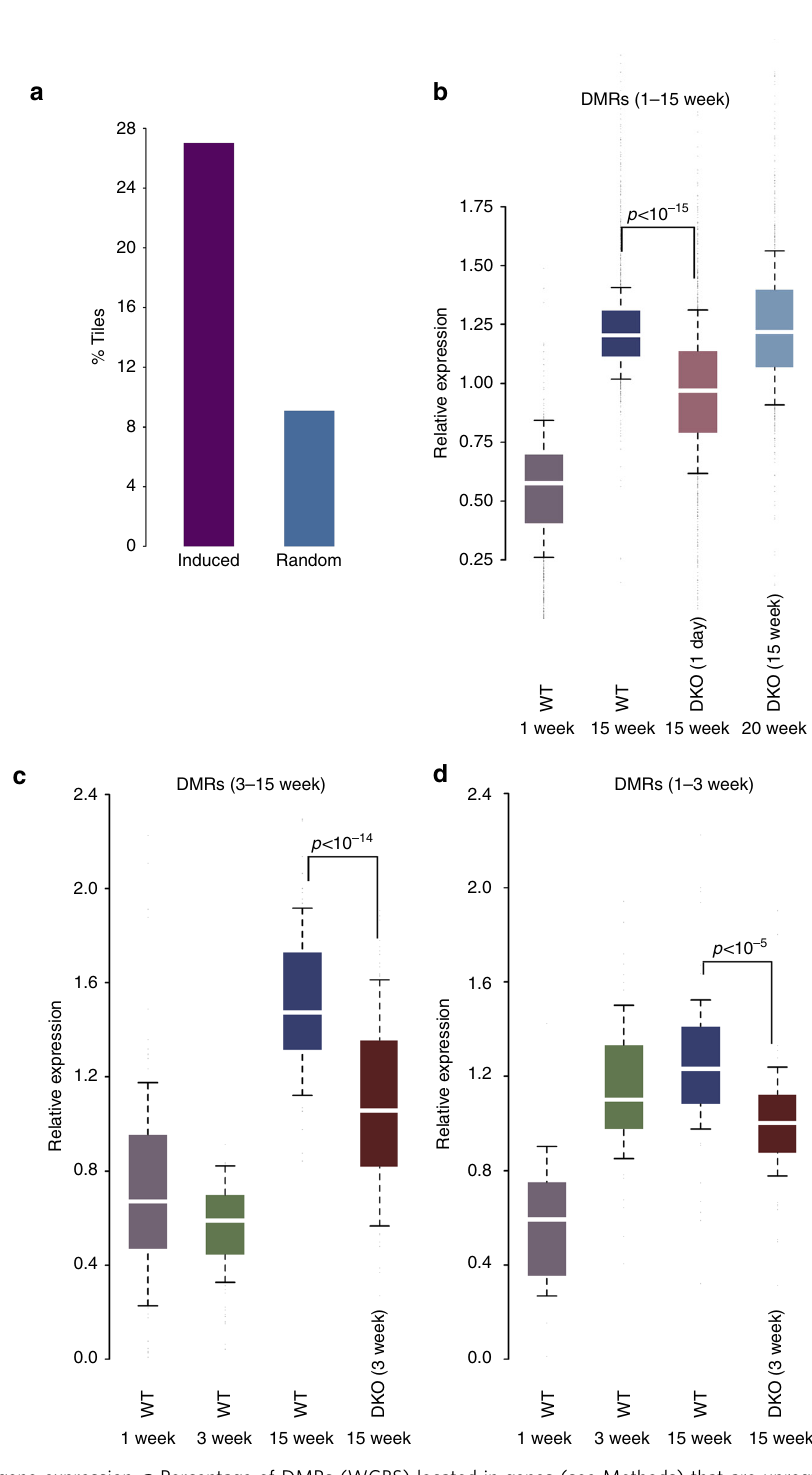
Fig. 3 Demethylation and gene expression. a Percentage of DMRs (WGBS) located in genes (see Methods) that are upregulated with age ( n = 8500) compared to randomly selected DNA segments ( p value <10 − 27 , z -test of proportions). b Box plots of relative expression (normalized fragments per kilobase million (FPKM)) in WT and Tet2/Tet3-de fi cient hepatocytes for 1212 genes upregulated after birth that contain intragenic DMRs. The DKO was induced at either 1 day or 15 weeks. Similar results were obtained using WT animals injected with AAV8-cre. c Expression of 115 genes that undergo demethylation (RRBS) and that are upregulated between 3 and 15 weeks. The DKO was induced at 3 weeks. d Expression of 47 genes that undergo demethylation (RRBS) and that are upregulated between 1 and 3 weeks. The DKO was induced at 3 weeks. In the DKO, the pattern of expression at 15 weeks was very similar to that of WT animals at 3